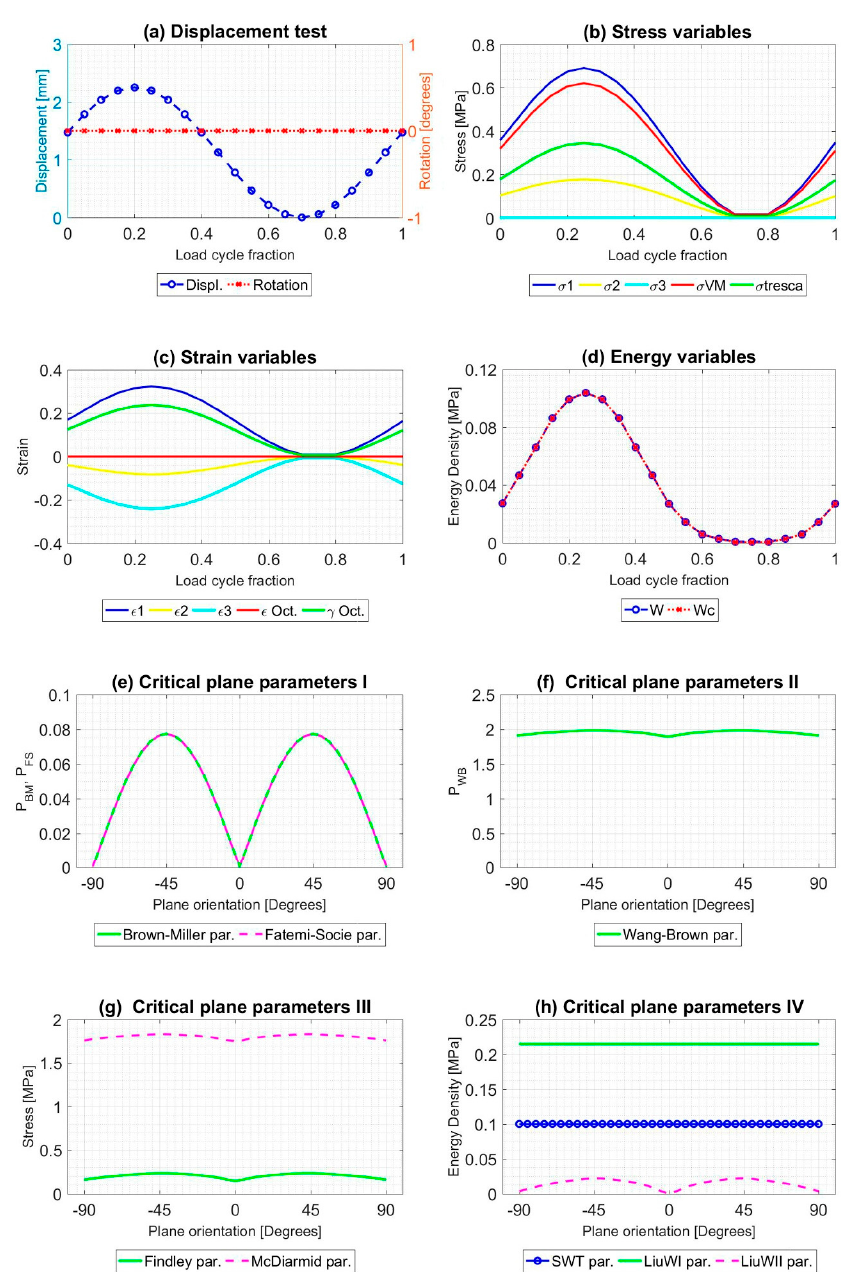
Figure 8. Result of the mechanical simulation of test A1 at the failure point of the sample caused by fatigue. Initial data from [46]